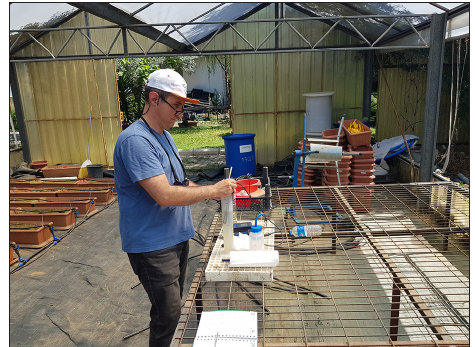
Figure 5. Measurement of drainage amounts